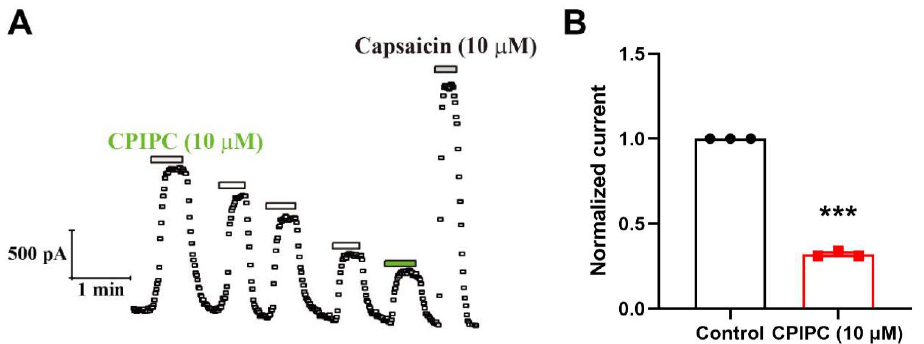
Figure 5. Induction of outward current desensitization by repetitive CPIPC in capsaicin-sensitive DRG neurons. ( A ) Time course of outward currents before and after application of 10 µ M CPIPC and capsaicin measured at +80 mV. ( B ) Normalized outward current amplitude for comparison between first and last applications of 10 μM CPIPC ( n = 3). ***, p < 0.001.